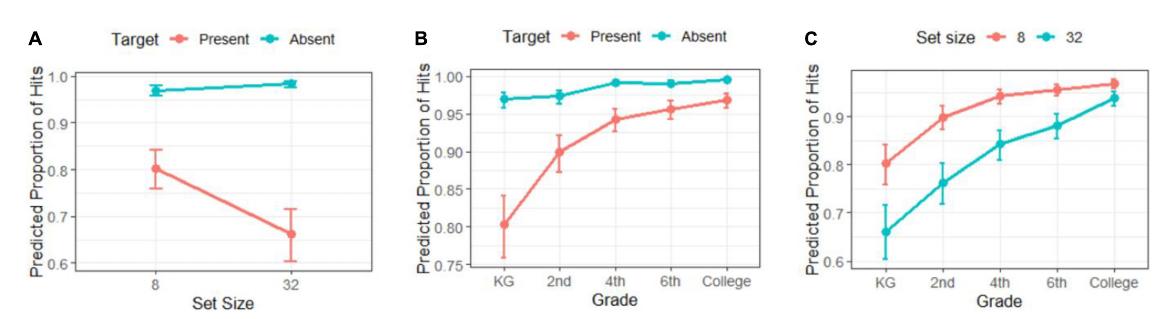
likelihood of showing these errors was lower with age regardless of memory load. The effect of set size was only significant for the false alarms: it was more likely to have a false alarm with 32 objects on the screen than with 8